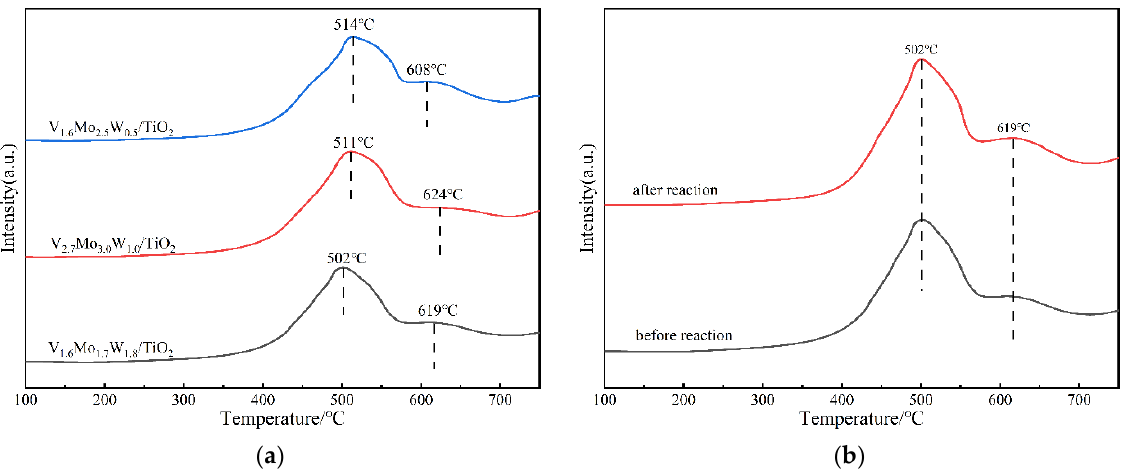
Figure 10. H 2 -TPR profiles of the three catalysts: ( a ) the three fresh catalysts and ( b )